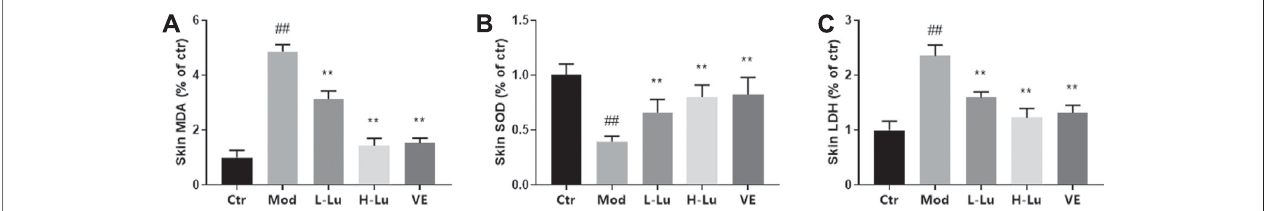
FIGURE 2 | Luteolin protects the skin from UVB-induced oxidative damage. (A) The contents of MDA in skin tissues. (B) The contents of SOD in skin tissues. (C) The contents of LDH in skin tissues. # indicates signi fi cant difference between the model group and the blank group (# p < 0.05; ## p < 0.01); * indicates signi fi cant difference between the administered group and the model group (* p < 0.05; ** p <